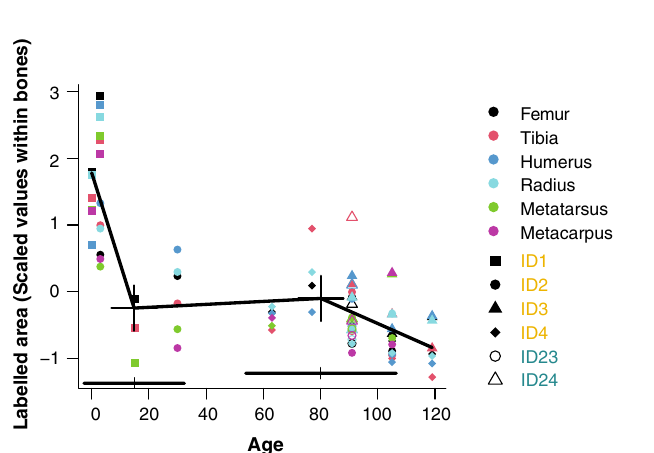
Figure 4. Amount of bone area stained with fluorochromes for each of the labels in six different limb bones. Plotted are scaled values of deposition areas in mm 2 of calves nursed by their mothers (C1: ID-23, ID-24), and hand-raised calves (C2: ID-1, ID-2, ID-3, ID-4. Crosses indicate breakpoints estimated by segmented regression, horizontal bars above the x-axis 95% confidence intervals of breakpoint locations. Slopes of regressions divided by breakpoints differed significantly (F (2,46 ) = 14.33, p < 0.0001; linear modelling without breakpoints yielded a significantly worse fit (model without breakpoints AIC = 179.66; model with breakpoints AIC = 132.59; ∆AICc = 47.07, p <